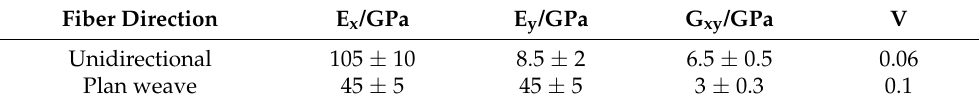
Table 3. Material properties of